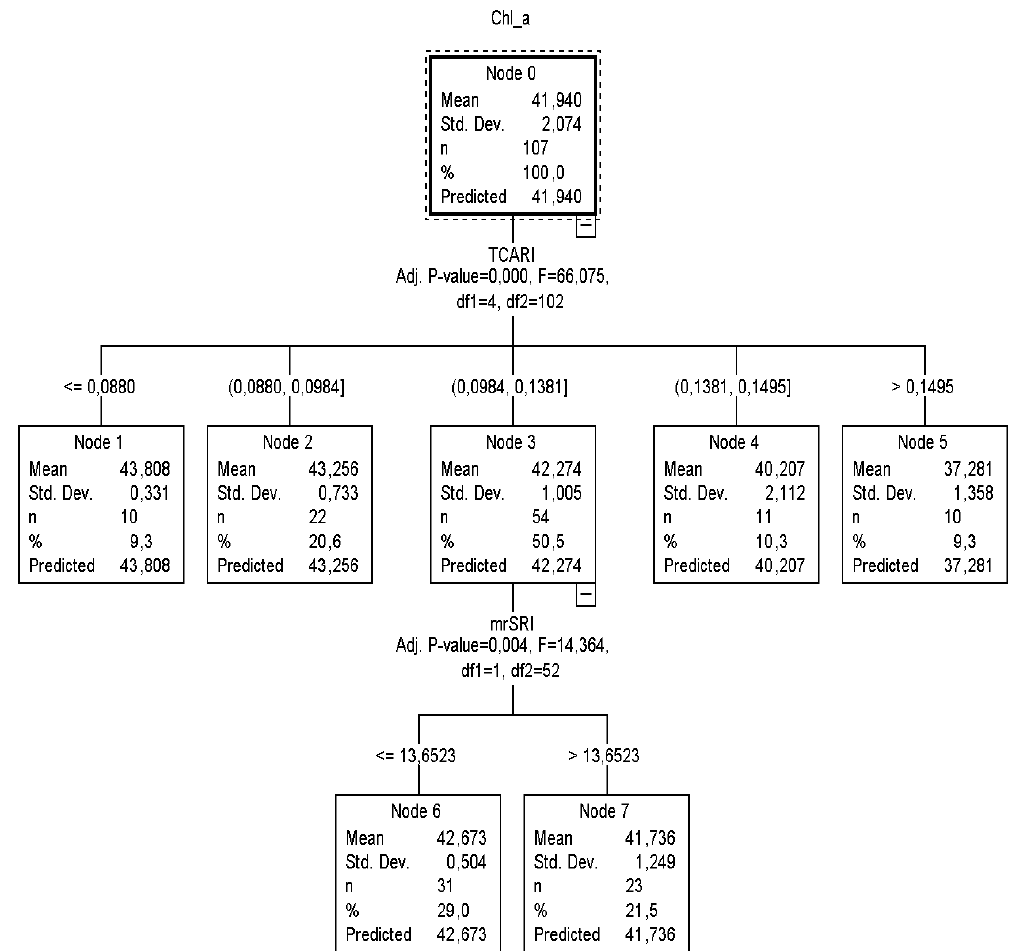
Figure 3. The CT2 classification tree of the training sample for calibration to predict Chl_a concentration in the leaf area (μg cm − 2 ).